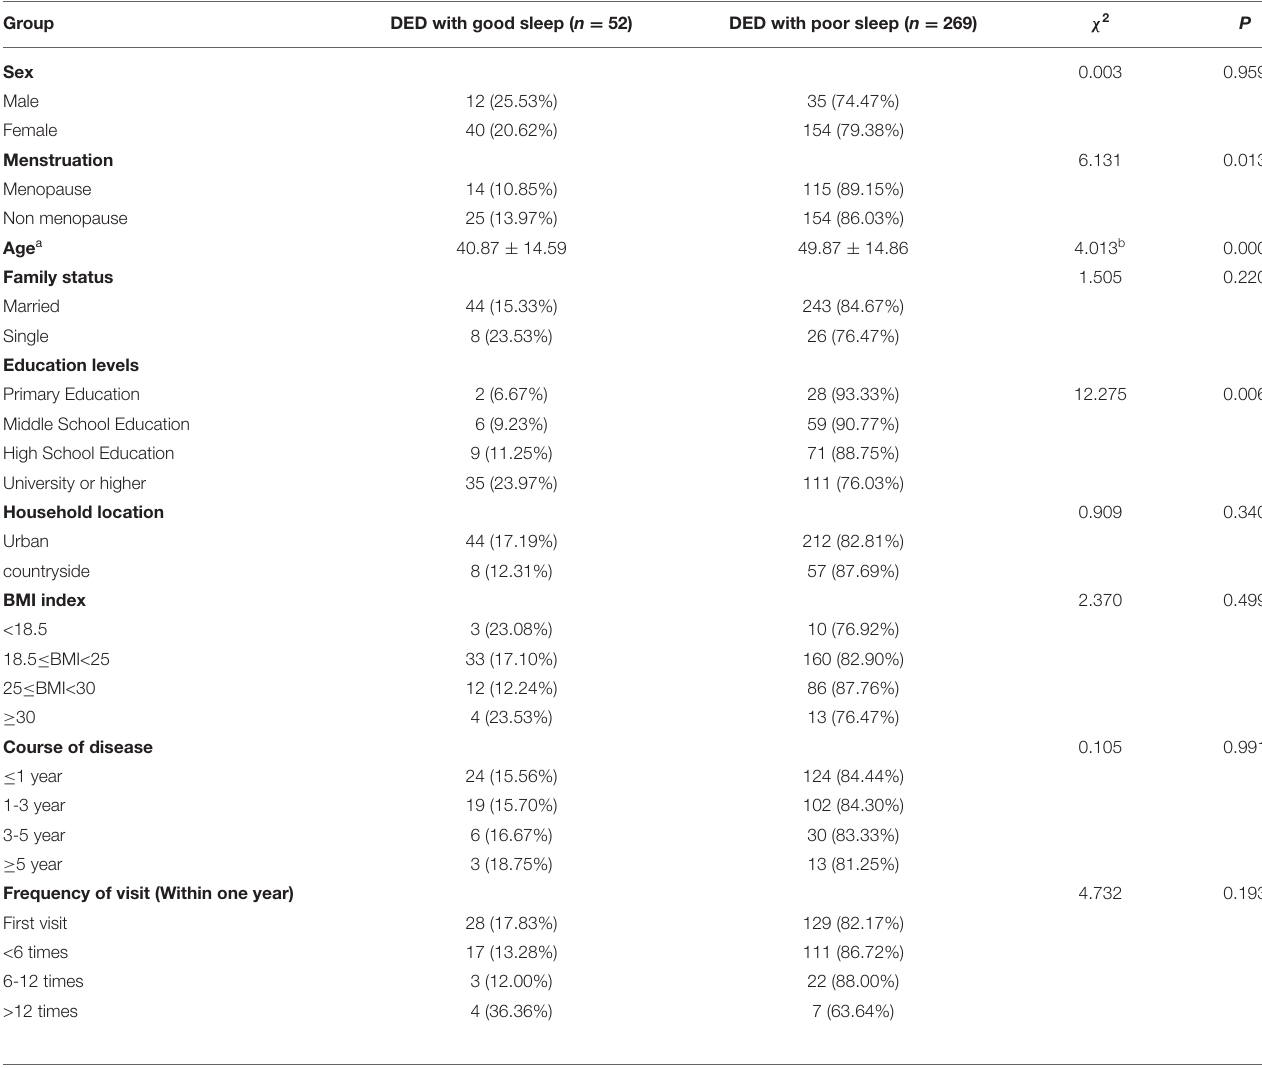
TABLE 1 | Comparison of demographics in patients with DED With good sleep or poor sleep. Group DED with good sleep ( n = 52)